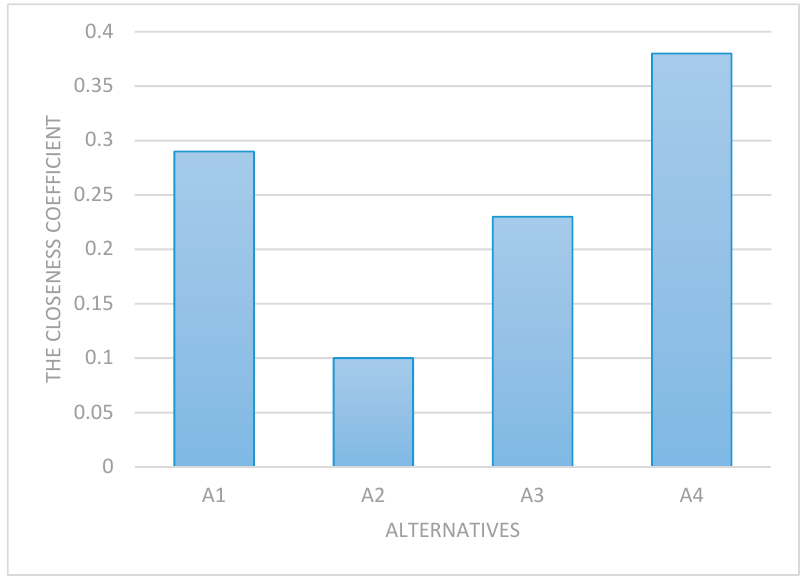
Figure 7. Final ranking using the suggested method.